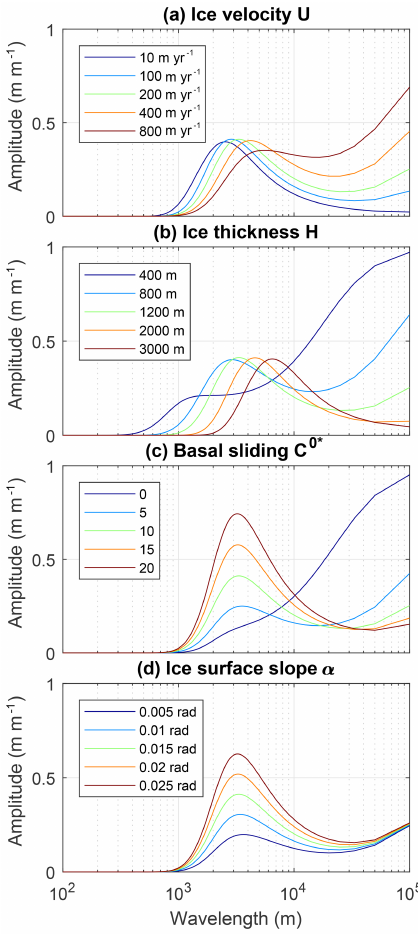
Figure 3. (a–d) Bed topography transfer function amplitudes in the ice flow direction (along an ice flow line). In all plots the pa- rameters not otherwise indicated are U = 200myr − 1 , H = 1200m, C 0 ∗ = 0, α = 0 . 015 radians, and η = 10 14 Pas. The spread of plot- ted parameters broadly encompasses the range of parameters found in our study regions (Fig. 1a, Table 1). Transfer amplitude peaks between around 1 and 10km for a wide range of parameters.